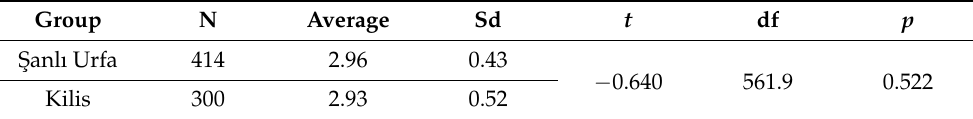
Table 4. The comparison of the opinions of refugees’ on healthcare services by provinces.